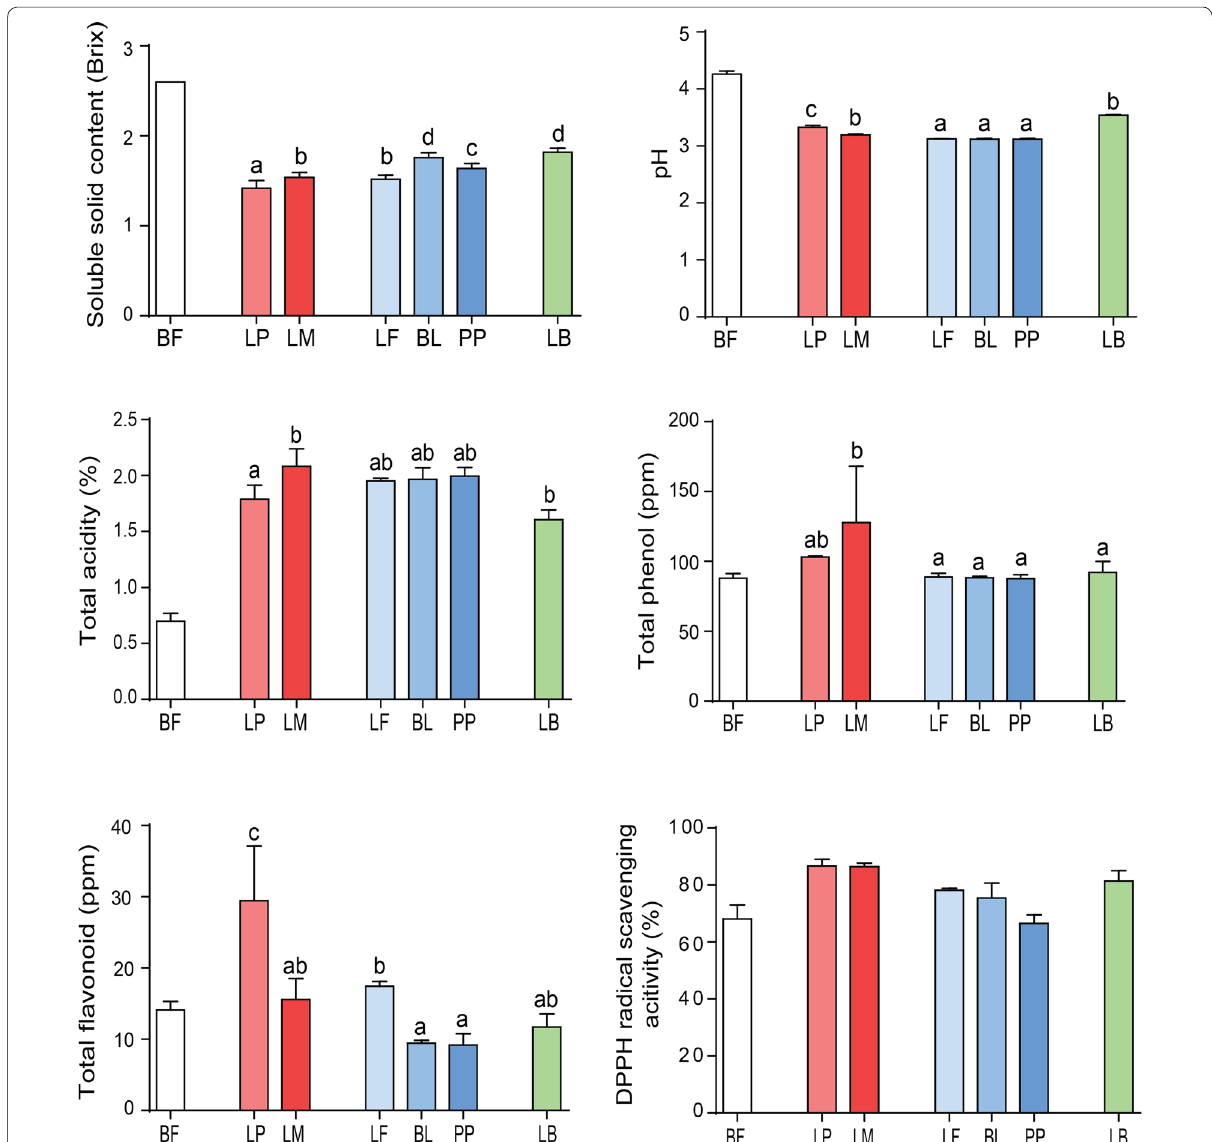
Fig. 1 Descriptive physicochemical and antioxidant properties of tomato samples fermented with different LAB strains. Means followed by different letters are significantly different between samples ( p < 0.05). BF before fermentation; LP Lactobacillus plantarum ; LM Leuconostoc mesenteroid ; LF Lactobacillus fermentum ; BL Bifidobacterium longum ; PP Pediococcus pentosaceus ; LB Lactobacillus